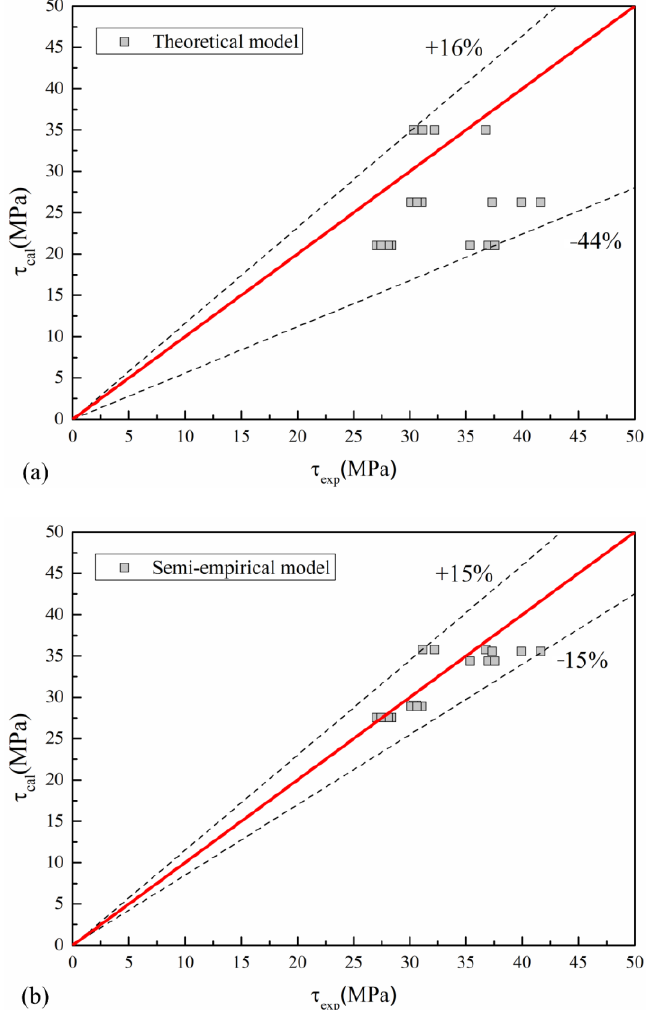
Figure 15. Comparison of the ultimate bond strength between estimated values and test data ( a ) Theoretical model ( b ) Semi-empirical model.